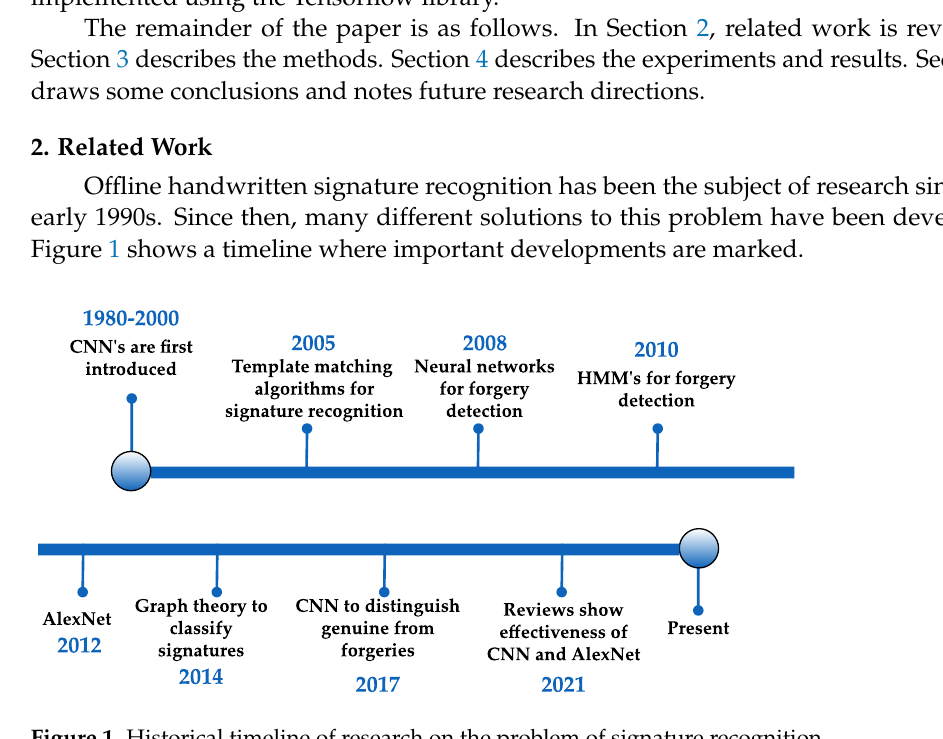
Figure 1. Historical timeline of research on the problem of signature